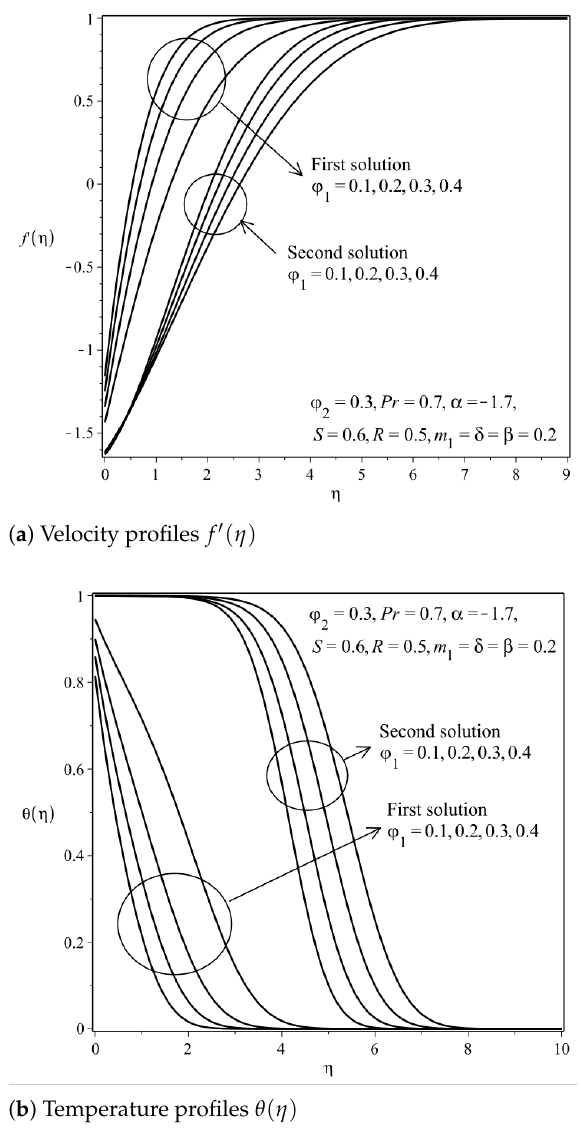
Figure 5. The flow of f (cid:48) ( η ) and θ ( η ) against φ 1